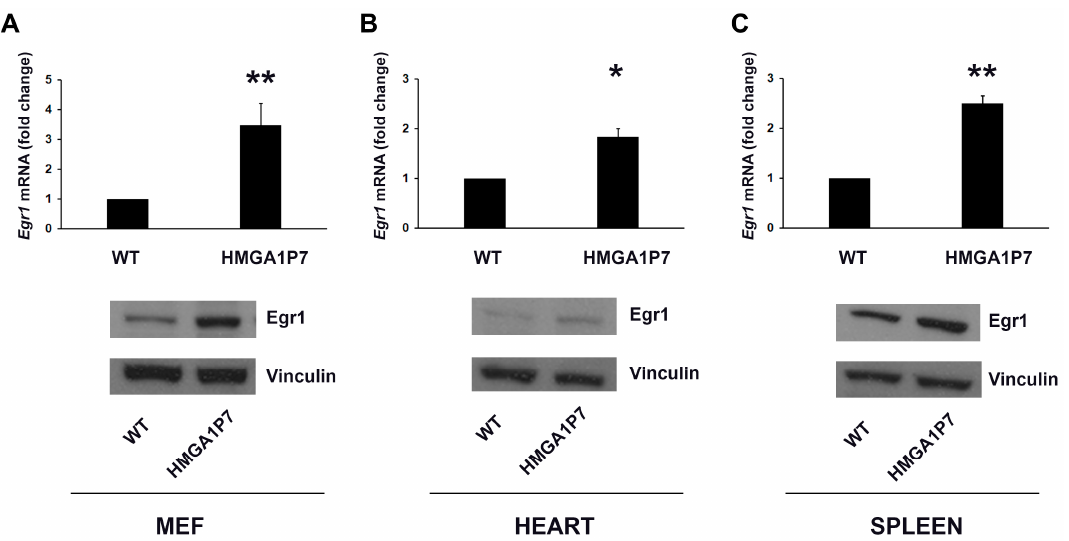
Figure 3. Egr1 is overexpressed in HMGA1P7 transgenic mouse tissues. qRT-PCR and Western Blot analyses of Egr1 levels in MEFs ( A ), hearts ( B ), and spleens ( C ) derived from WT and HMGA1P7 transgenic mice. The results are reported as the mean of values. The error bars represent mean ± SD; *: p < 0.05, **: p < 0.01 (t test).